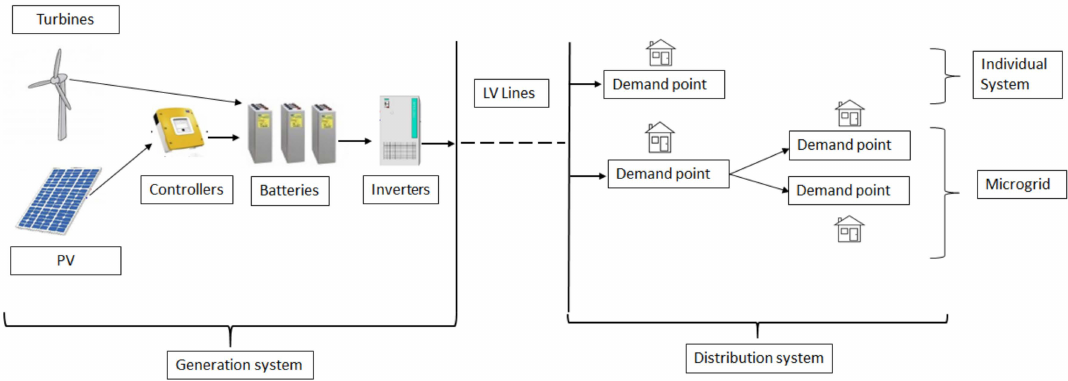
Figure 1. Scheme of the rural electrification systems (adapted from